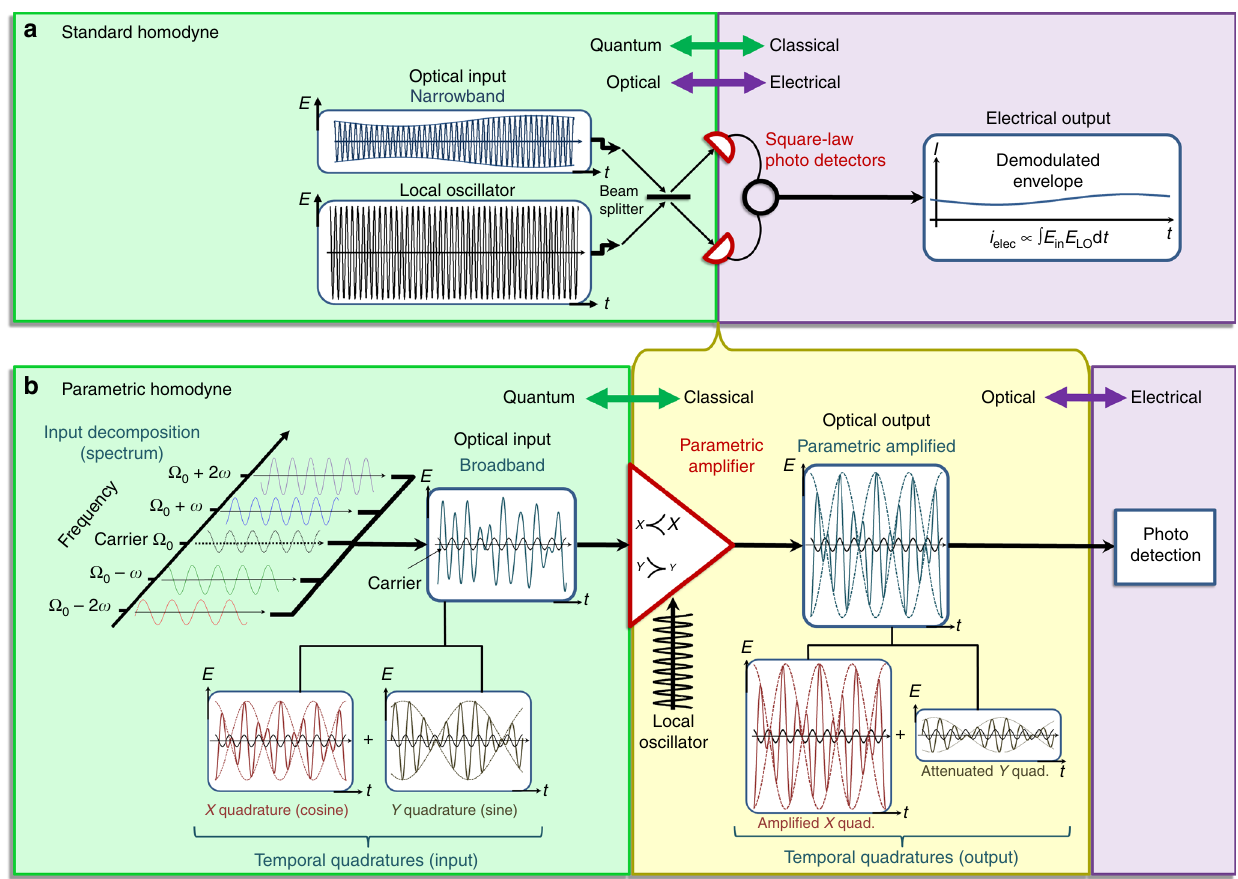
Fig. 1 Parametric homodyne vs. standard homodyne. a The standard homodyne measurement, where the electrical nonlinearity of two square-law photo- detectors in a balanced detection scheme is used to multiply the quantum input fi eld with the LO. The photo-detection (and the homodyne gain associated with it) mark the transition from a quantum optical input (green frame) to a classical and electrical output (purple frame), where a severe bandwidth limitation is imposed by the electronic detection. b The parametric homodyne method uses an optical parametric ampli fi er to amplify the quantum quadrature of interest to a classical level (and attenuate the other) already in the optical domain before the photo-detection, thereby generating an optical intermediate signal (light yellow frame), which is already classical, yet preserves the full optical bandwidth of the quantum input, and allows parallel photo- detection and classical manipulation over the entire bandwidth. In the illustration, the broadband optical input is composed of four frequency components (two-mode pairs), such that the Ω ± 2 ω mode-pair generates a fast beat envelope only on the x quadrature, and the Ω ± ω mode-pair generates a slower beat envelope only on the y quadrature. The total broadband optical fi eld conceals the quadrature information, but after the parametric ampli fi er, the x quadrature is ampli fi ed and the y quadrature is attenuated, such that the resulting parametric output is almost entirely proportional to the x quadrature, rendering the fast x beat clearly visible. The small black oscillation plotted on top of the various fi elds is a cosine local-oscillator reference to identify the